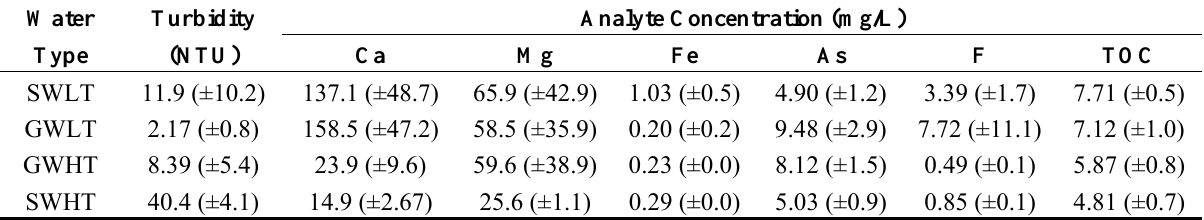
Table 2. Physicochemical profile of water sources before treatment (mean ± standard deviation) together with SANS 421 [6] and the World Health Organization guideline values [14] for drinking water.